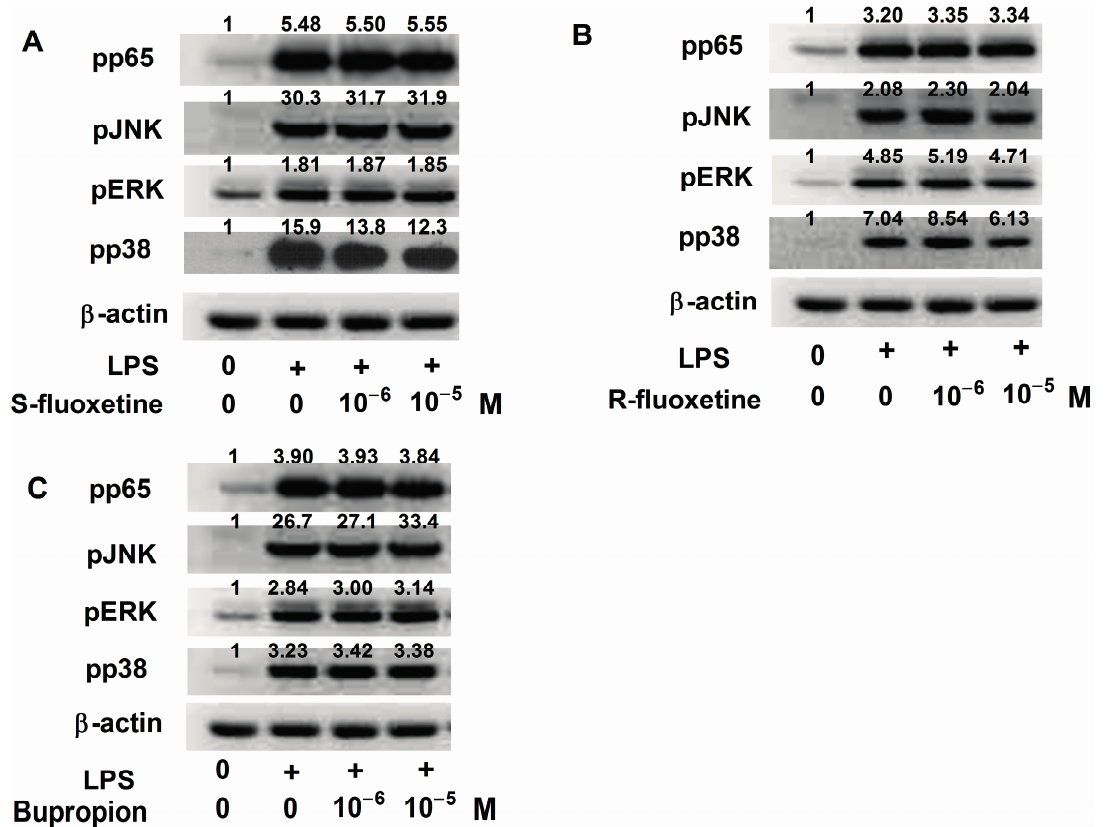
Figure 5. S-fluoxetine ( A ) and R-fluoxetine ( B ); but not bupropion ( C ), suppressed LPS-induced pp38 expression. S-fluoxetine, R-fluoxetine and bupropion had no effect on LPS-induced pp65, pJNK and pERK expression. Relative optic density of each band on Western blot to the control group was